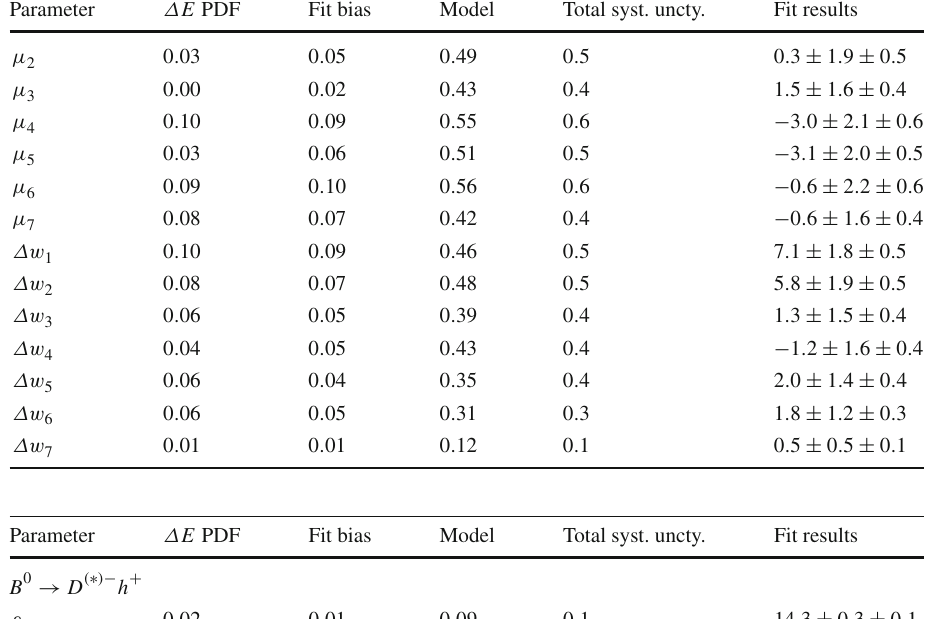
Table 6 Results for ε i , w i , μ i , and Δw i for the DNN tagger: systematic uncertainties associated with the Δ E parametrization, fit bias, and fit model, and total systematic uncertainty are shown together with the fit results (with stat. and syst. uncertainty). The results are given in